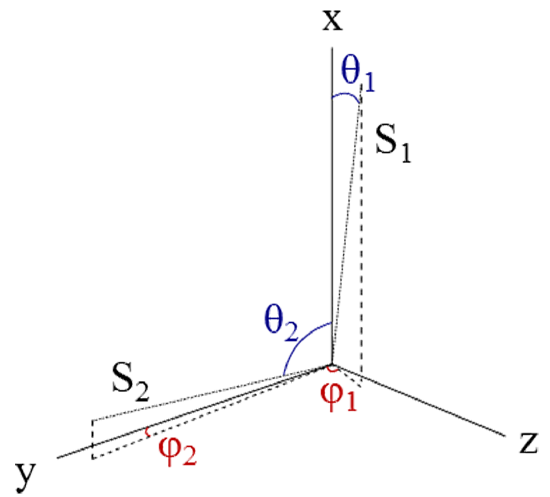
Figure 1. The relation between the orthogonal ( x , y , z ) and sensor ( S 1 , S 2 , S 3 ) coordinate systems. The elevation and azimuthal angles θ and ϕ for each sensor coordinate are defined in the same way. S 3 has been omitted for